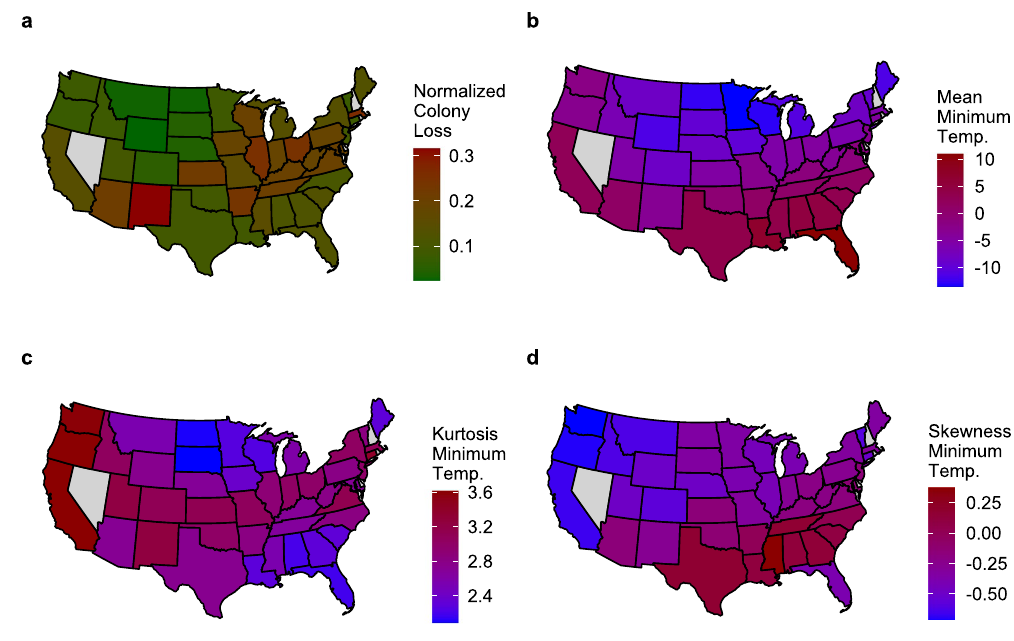
Figure 5. Spatial representation (by state) of median values for four different indices regarding colony loss and minimum temperature in the first quarter (January-March) of seven consecutive years (2015–2021) for each state. ( a ) Normalized honey bee ( Apis mellifera ) colony loss. ( b ) Mean of minimum temperatures. ( c ) Kurtosis of minimum temperatures (how “extreme” the minimum temperatures were). ( d ) Skewness of minimum temperatures (whether they tended to concentrate in their lower or upper range). In each panel, the color attributed to a state represents the median of seven index values (first quarter of seven years). North Dakota shows a relatively low normalized colony loss (panel ( a )), one of the lowest mean minimum temperature (panel ( b )), and one of the lowest minimum temperature kurtosis (panel ( c )). This suggests that consistently low minimum temperatures during the first quarter (low mean and low kurtosis) may be associated with lower colony loss in that state. The map has been generated by the authors in R 3.6.2 49